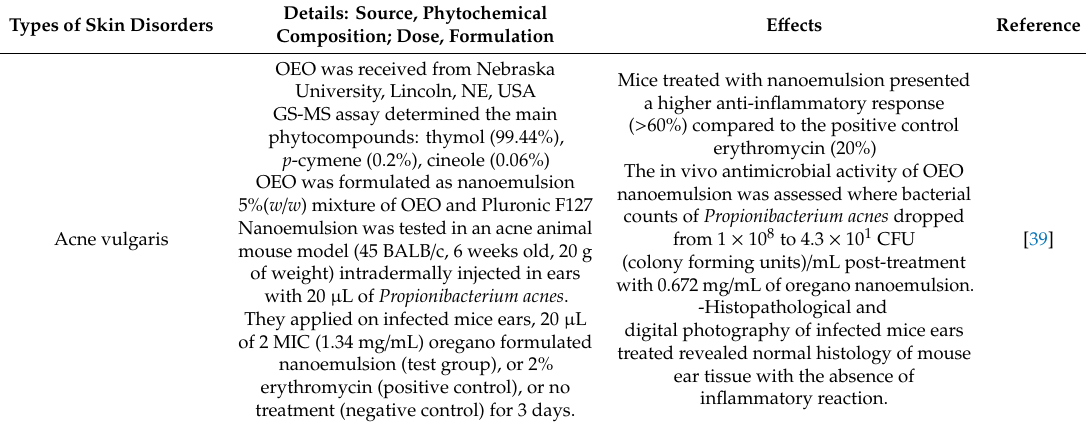
Table 8. Beneficial e ff ects of Origanum vulgare L. essential oil (OEO) on skin disorders. Types of Skin